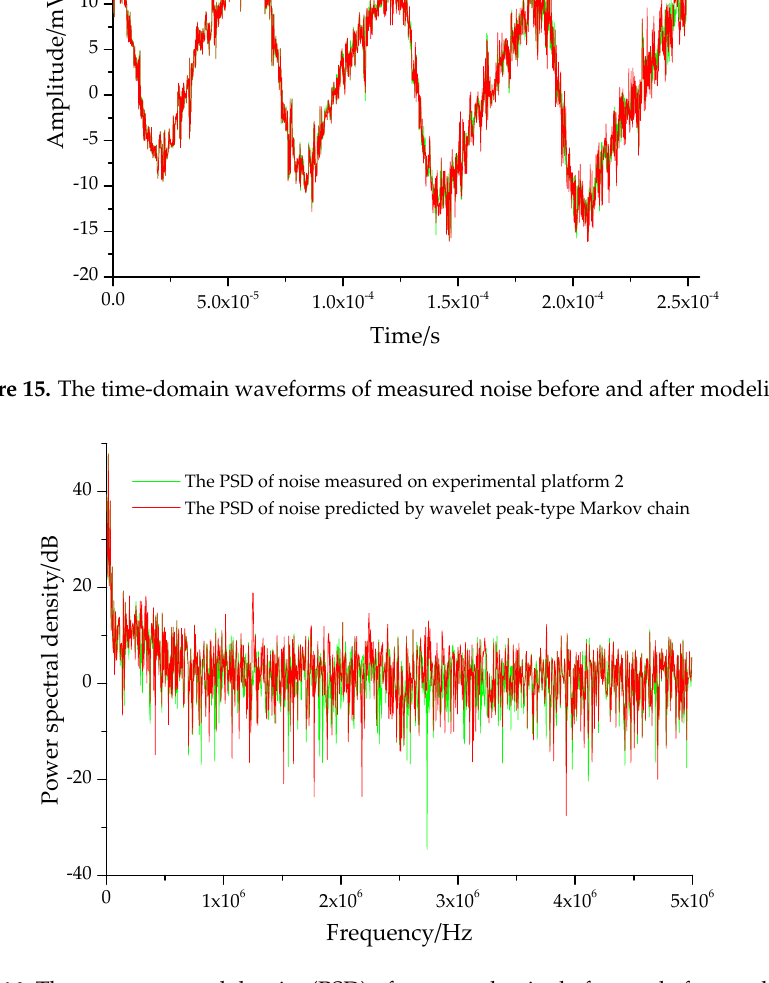
Table 2. The predicted error for modeling the noise measured in experimental platform 1 and 2. Experimental Platform